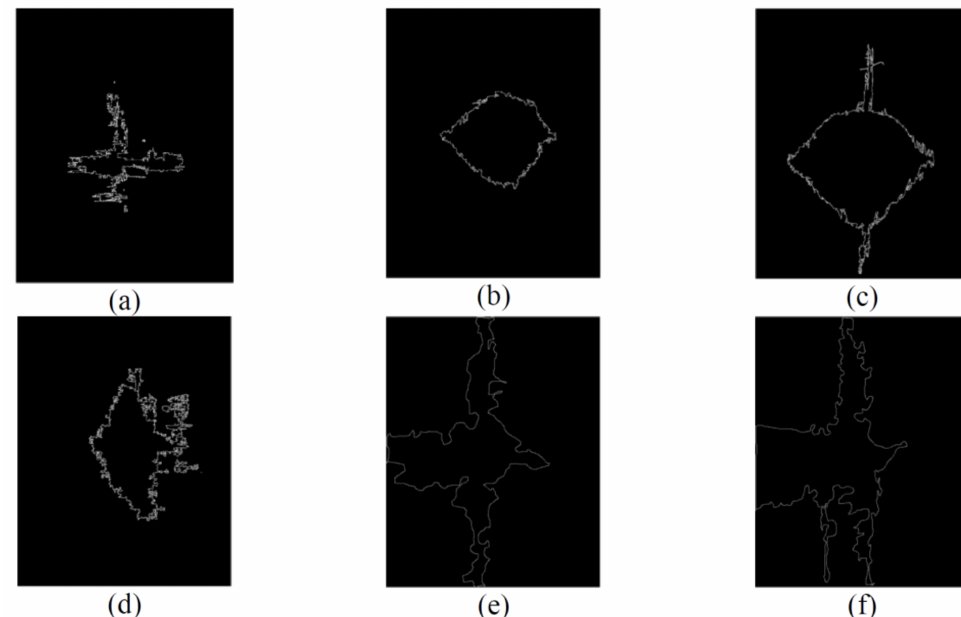
Figure 6. Damage area on the T700/PA6.6 post-LVI at 40 J, 100 J and 160 J: ( a ) 683 mm 2 , ( b ) 1502 mm 2 and ( c ) 2705 mm 2 ; T700/PPS post-LVI at 40 J, 100 J and 160 J: ( d ) 1781 mm 2 , ( e ) 6686 mm 2 and ( f ) 7098 mm 2